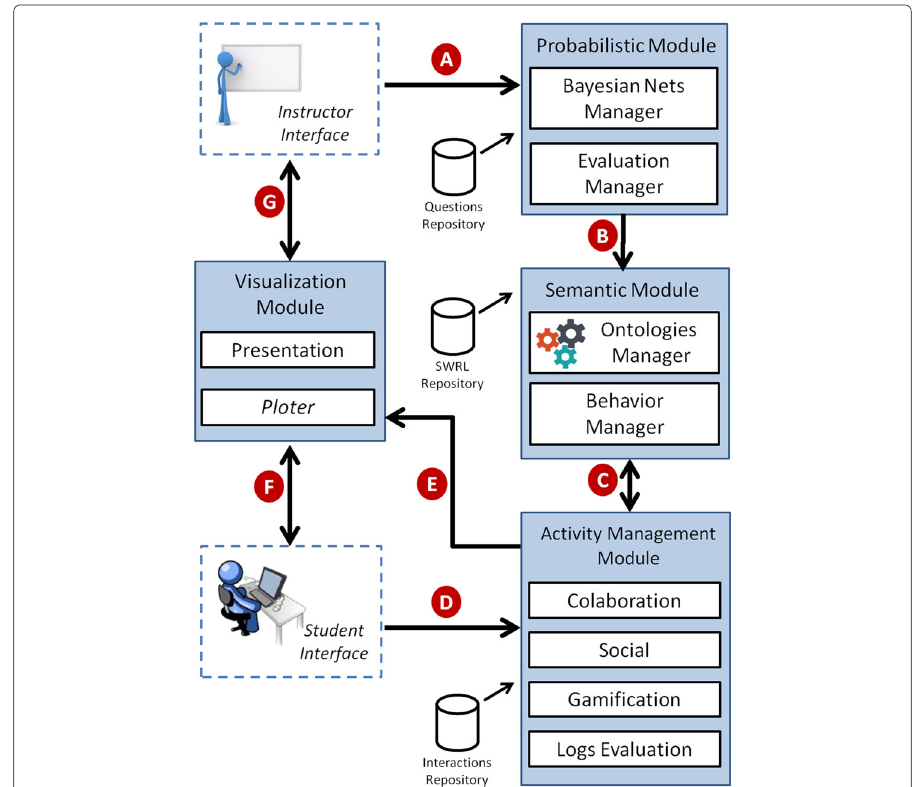
Fig. 2 OSM-V architecture. Overview of OSM-V architecture, consisting of four modules: Probabilistic Module, Semantic Module, Activity Management Module and Visualization Module (source: (Ferreira et al. 2019))